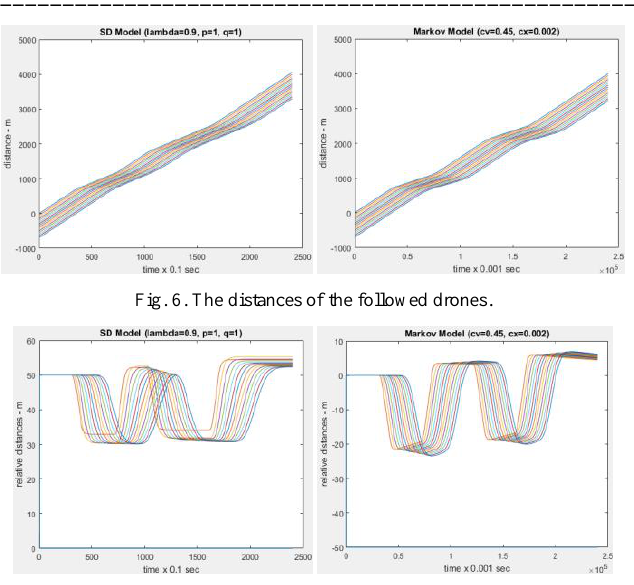
Fig. 7. The relative distances of the followed drones.